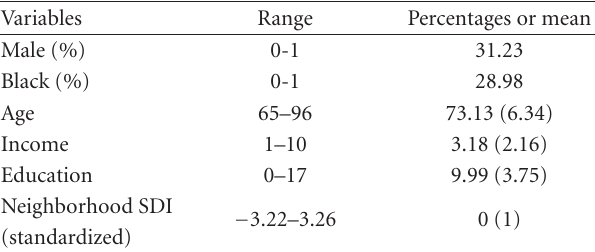
Table 1: Descriptive statistics (unweighted): percentage distribu- tion or mean (standard deviation in parentheses) at baseline for independent variables (respondents aged 65 and above at baseline, N =